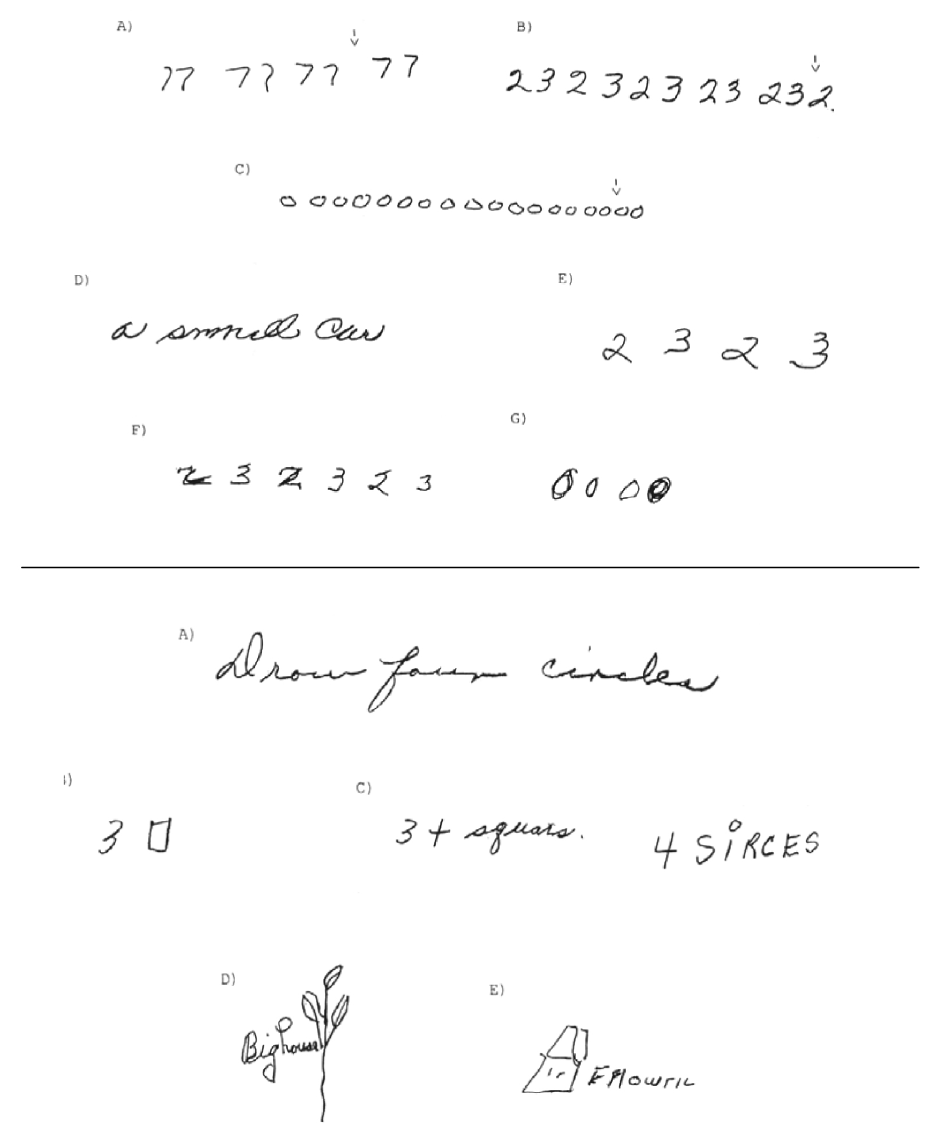
Fig. 1. Top panel display various hyperkinetic perseverations (A-G) made by individuals with vascular dementia associated with white matter alterations. Bottom panel displays various semantic perseverations (A-E) made by individuals with Alzheimer’s disease and little to no white matter